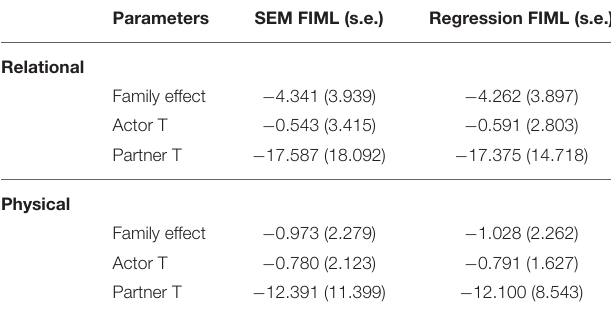
TABLE 6 | Casestudy: SRM-components as predictor. TABLE 7 | Casestudy: SRM-components as